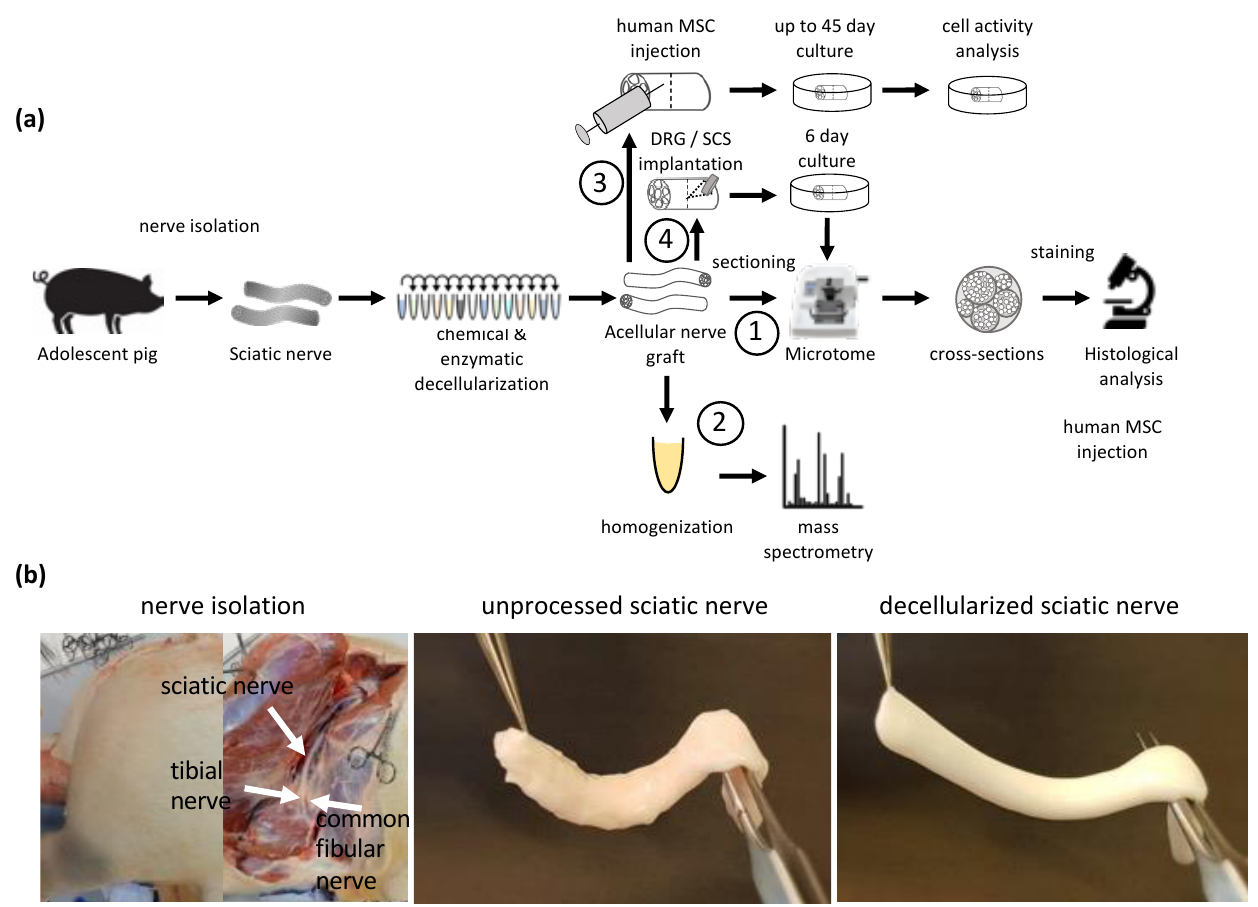
Figure 1. Experimental overview: ( a ) Illustration of the experimental setup. Sciatic and common fibular nerves of adolescent pigs were isolated. Following isolation, the nerves were treated with a series of various chemical and enzymatic detergents for decellularization. The resulting acellular nerve grafts were analyzed and tested in different ways. (1) Cross-sections via microtome were made from acellular graft and used for immunohistochemistry. (2) Proteomic analysis of the acellular graft to detect the number of removed peptides and known inhibitors of axonal regeneration due to the decellularization process. (3) Acellular grafts were used as 3D scaffolds for cell culture. Cells in the 3D scaffold were cultured for up to 45 days and cellular behavior was analyzed by measuring cellular metabolism via resazurin. (4) Dorsal root ganglion (DRG) and Spinal cord segments (SCS) were implanted in acellular grafts and cultured for 6 days prior to fixation, sectioning and histological analysis; ( b ) Representative images of nerve isolation from adolescent pigs. Unprocessed sciatic nerve with excessive fat and connective tissue and a reddish color, Decellularized sciatic nerve with removed excessive tissue and white appearance.